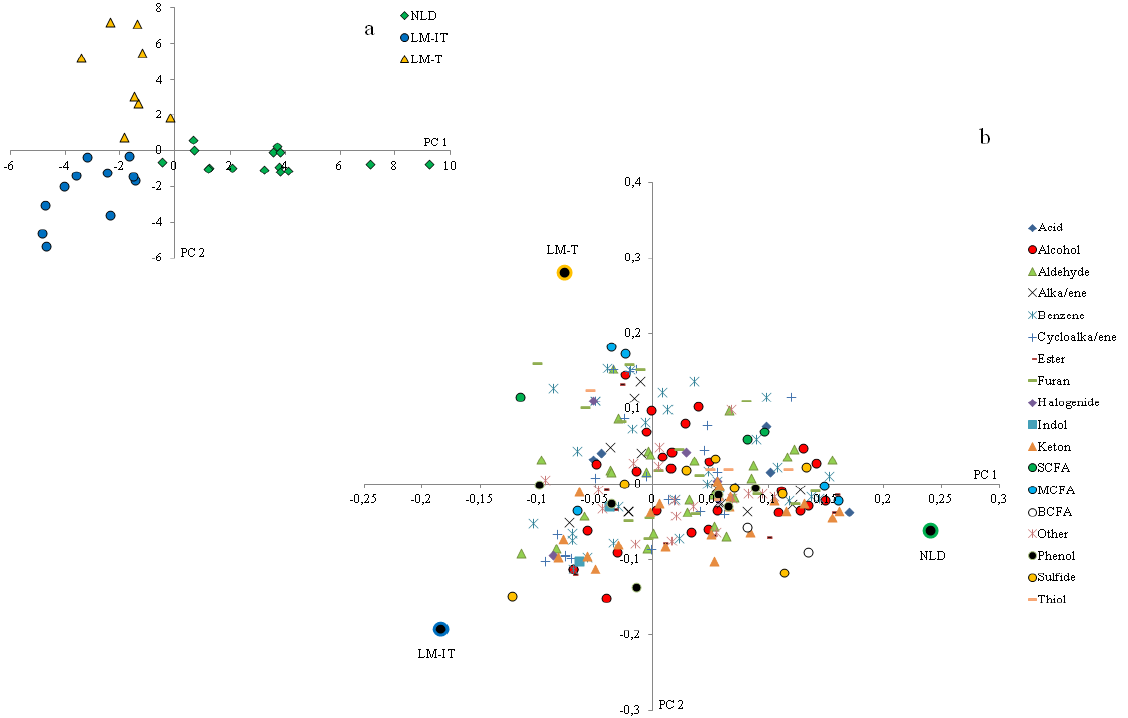
Figure 5. ( a ) Results of multivariate analysis of fecal metabolite profiles after 24 h incubation with lactose. Relative indices of the metabolites detected in the fecal samples collected by LM-IT, LM-T and NLD at baseline were used for a supervised clustering analysis by a partial least squares-discriminant analysis. The resulting loadings for principal components (PC) 1 and 2 are shown; ( b ) The bi-plot shows the metabolites divided in chemical classes and the mean of the samples for each intervention.